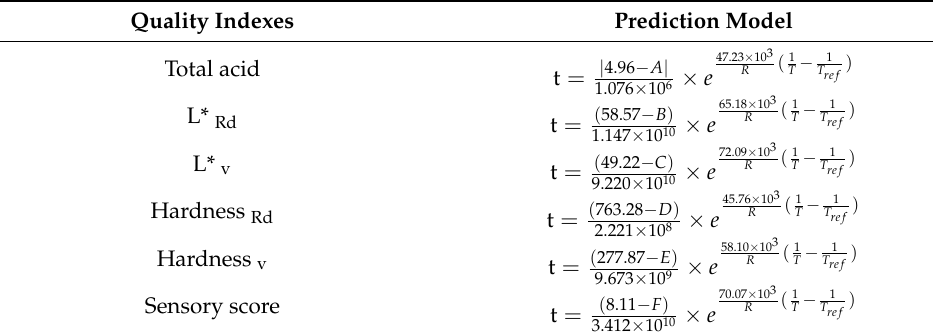
Table 7. Arrhenius model for predicting various quality indexes of Sichuan sauerkraut in differ- ent